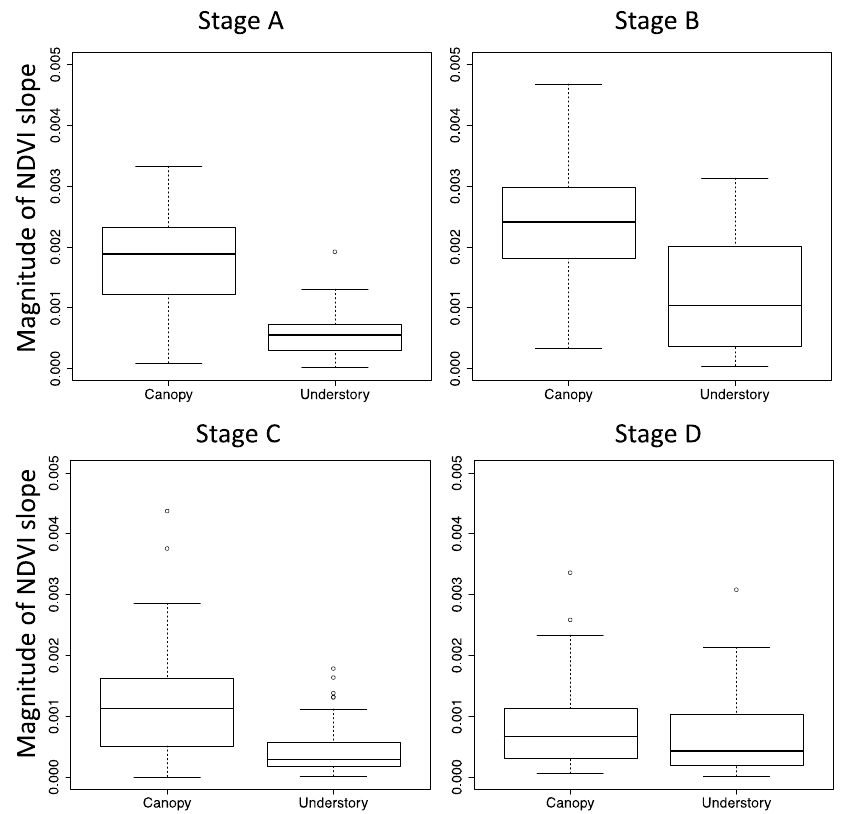
Figure 4. Boxplot of the NDVI slope in each phenological stage. Magnitude of NDVI slope indicates the absolute value of NDVI slope against solar zenith angle. NDVI values for each day were extracted and the slope was calculated. Stage E was not computed because of limited solar zenith angle range.